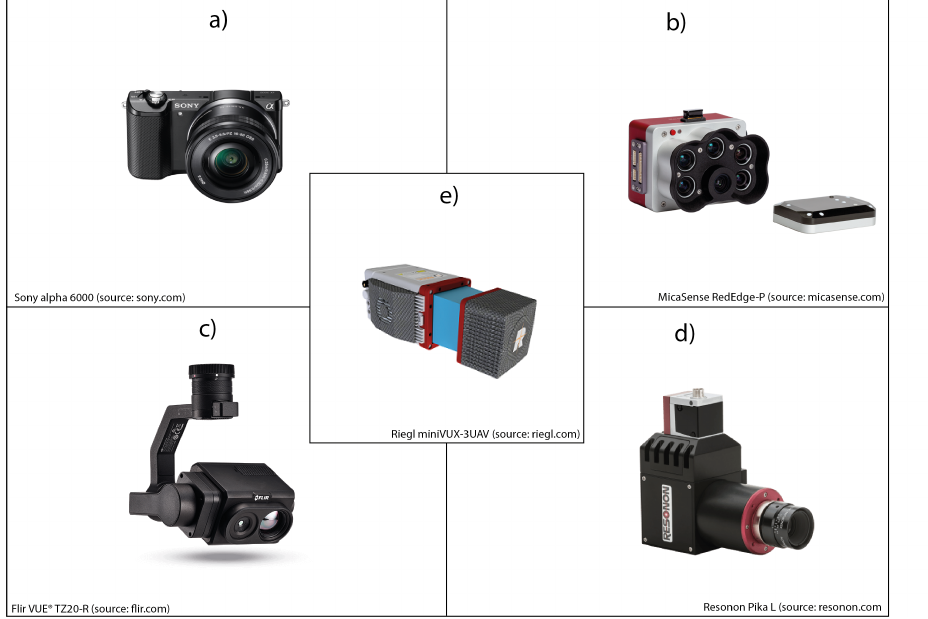
Figure 4. Different sensors for remote sensing applications that can be attached to UAVs: ( a ) RGB camera, ( b ) multispectral camera, ( c ) thermal camera, ( d ) hyperspectral camera, and ( e ) LiDAR